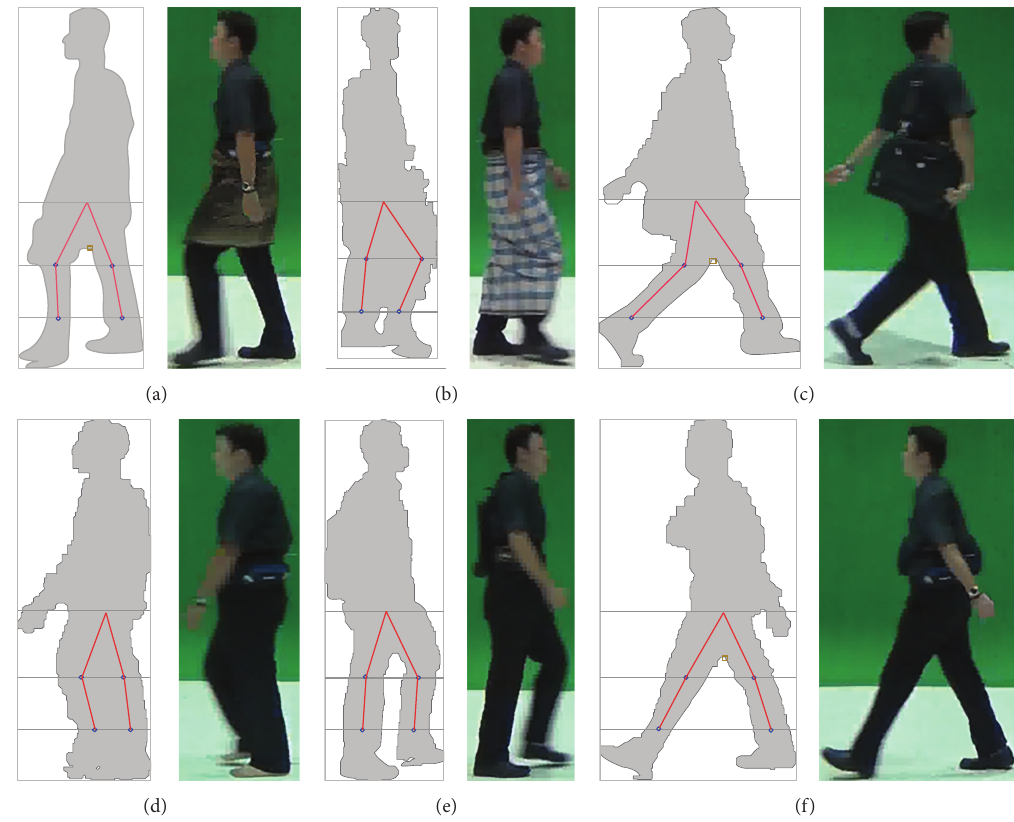
Figure 9: Occluded human silhouettes with joints detection. (a) Wearing “kain samping”. (b) Wearing “sarong”. (c) Barrel bag slung over shoulder. (d) Walking in bare feet. (e) Carrying rucksack. (f) Carrying barrel bag by hand.